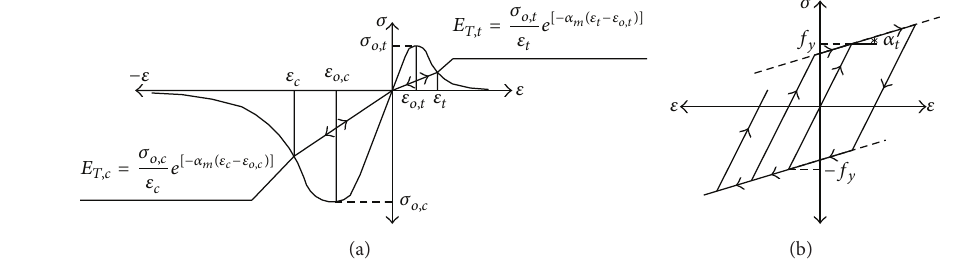
Figure 4: Stress-strain relationships of (a) concrete and (b) steel.